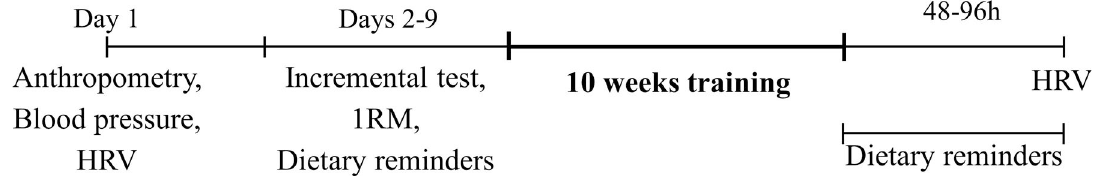
Figure 1 - Study design. HRV: heart rate variability; 1RM: one maximum repetition